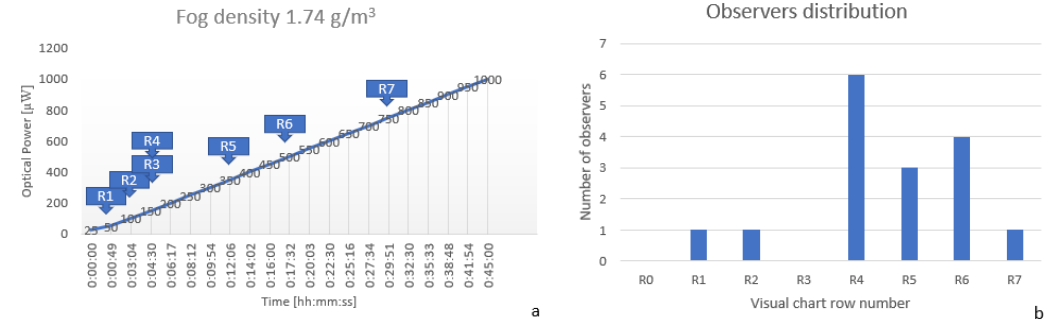
Figure 10. ( a ) Optical power and OCR measurements at a fog density of 1.74g/m 3 ( b ) Observers visual acuity distribution at a fog density of 1.74g/m 3 .